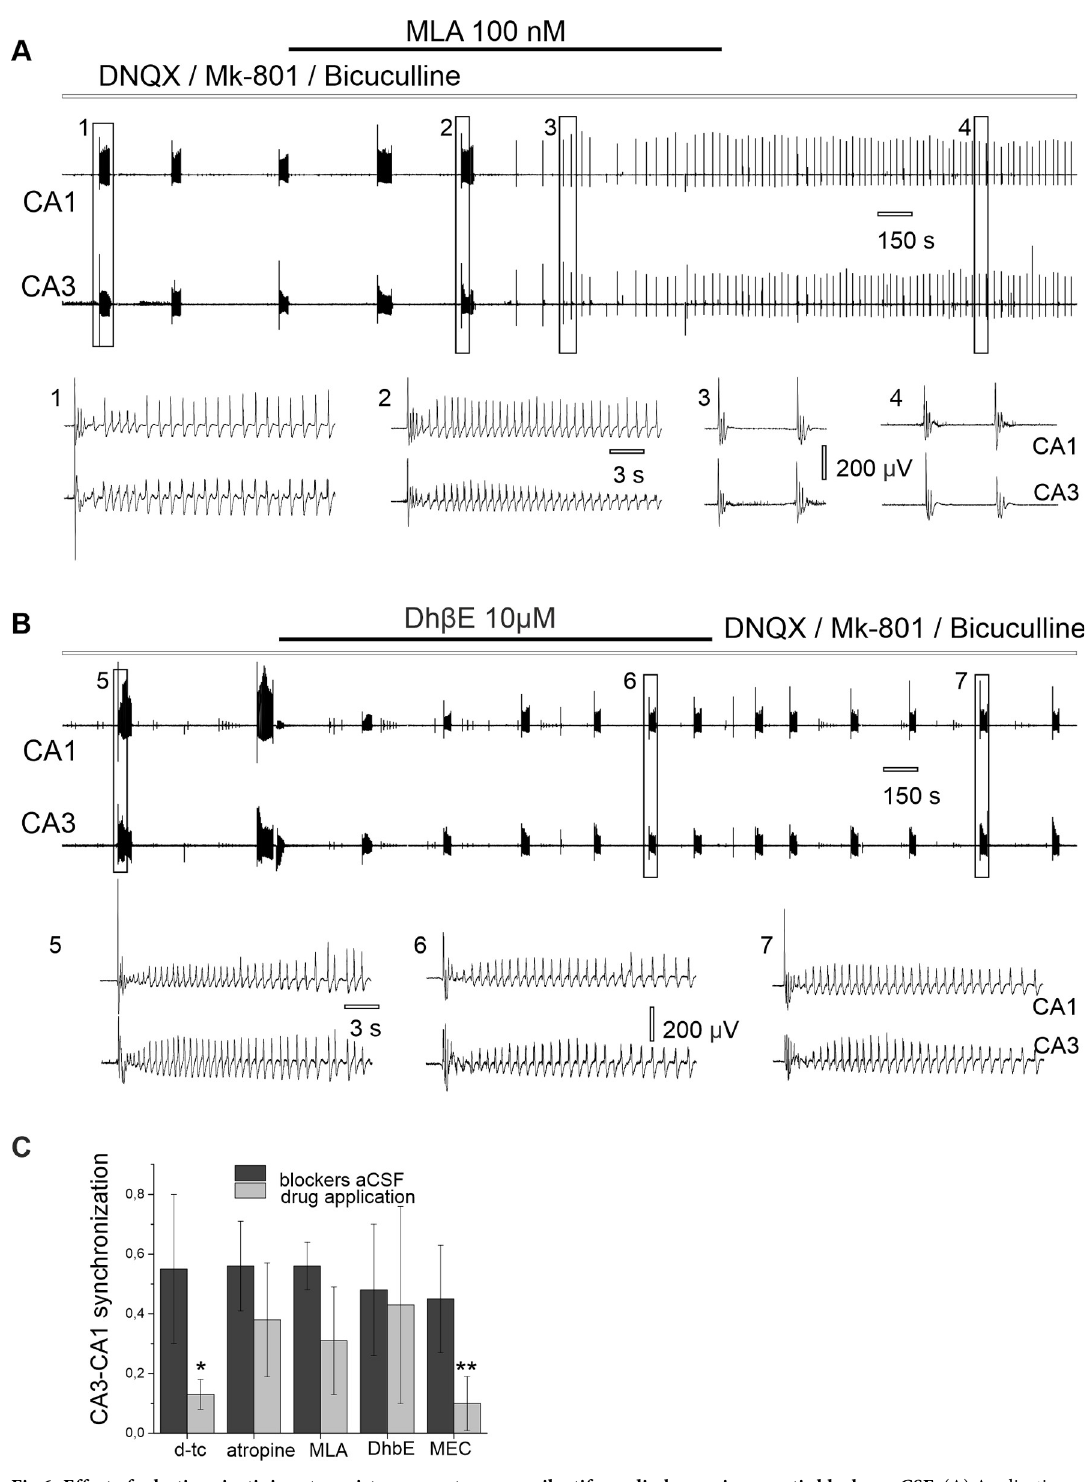
Fig 6. Effect of selective nicotinic antagonists on spontaneous epileptiform discharges in synaptic blockers aCSF. (A) Application of α 7 nAChRs antagonist MLA (100 nM) does not stop synchronous discharges: (1) burst of discharges in synaptic blockers aCSF; (2) burst of discharges during MLA application; (3) single field discharges in presence of MLA and (4) after wash out. (B) Synchronous burst of discharges appears in (1) synaptic blockers aCSF, (2) after Dh β E application, and after perfusion was returned to synaptic blockers aCSF (3). (C) Summary data of the effect of cholinergic antagonists on cross-correlation between CA3 and CA1 field potential in synaptic blockers aCSF. https://doi.org/10.1371/journal.pone.0240074.g006 PLOS ONE | https://doi.org/10.1371/journal.pone.0240074 March 12,